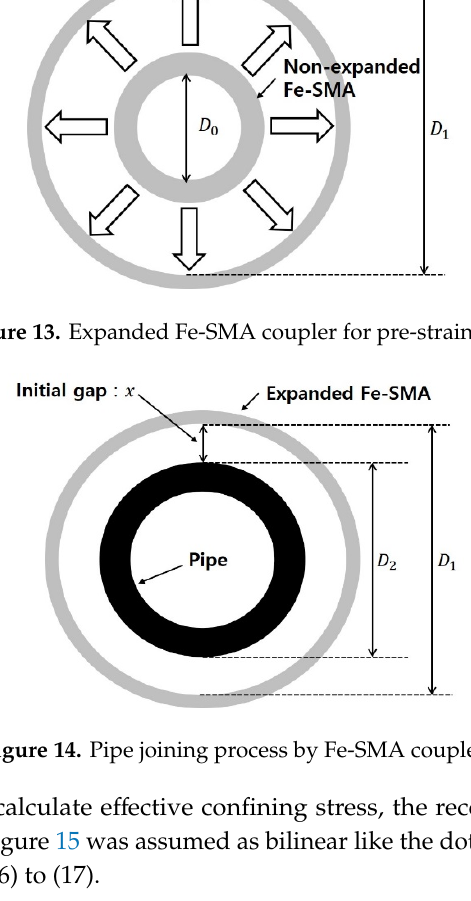
Figure 12. Recovery strain ‐ stress relationship of FSMA ‐ A and FSMA ‐ C.